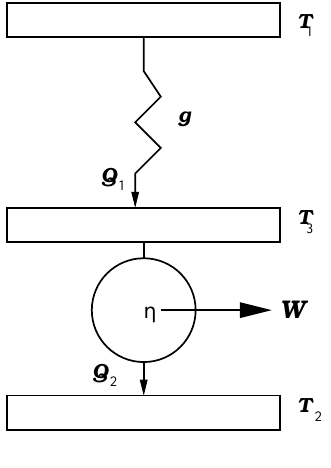
Figure 1. Novikov’s model for a nuclear power plant.